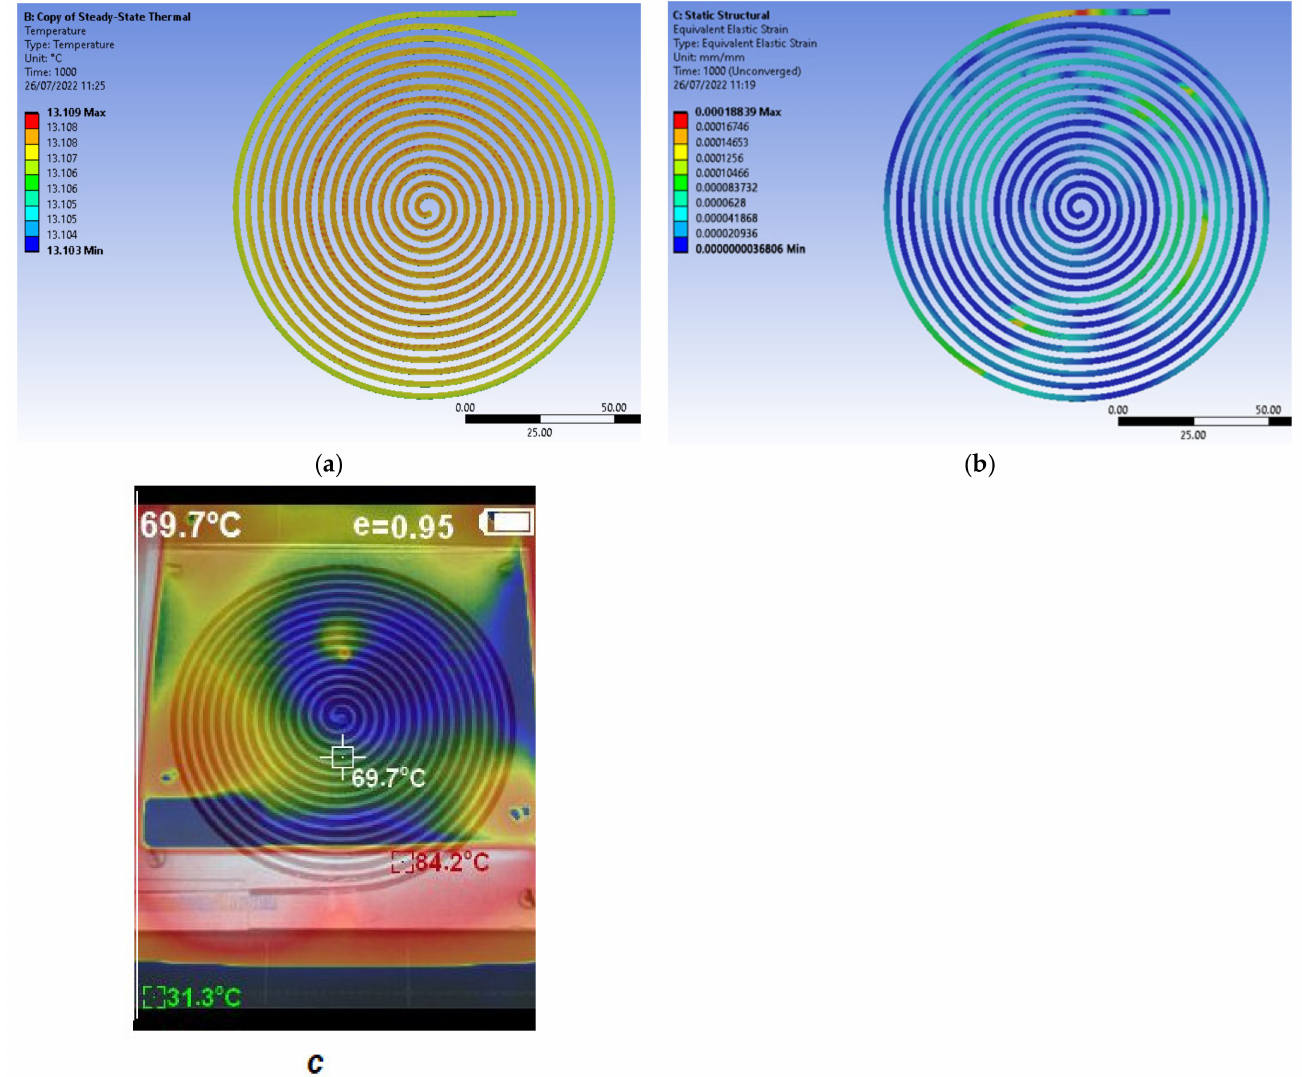
Figure 3. Uneven cooling/heating of the spiral test sample due to different heat transfer rates in distinct areas of the aluminum alloy plate: ( a ) temperature distribution in the steady-state thermal scenario; ( b ) equivalent elastic strain distribution in the static-structural scenario; ( c ) image obtained using the thermal imaging